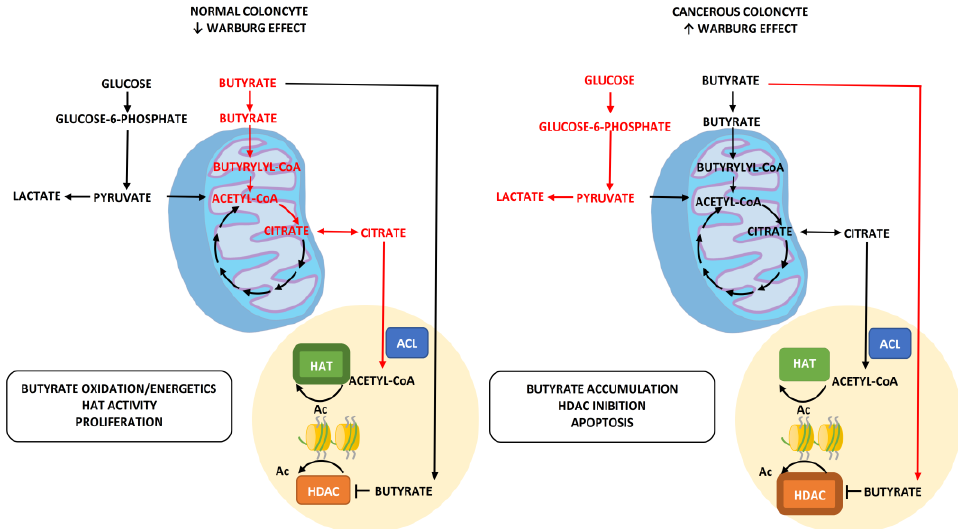
Figure 3. Oncosuppressive role of butyrate. Under normal conditions, butyrate is mainly used as an energy producer by cells. In those tumors, the energy is obtained in particular from glucose (Warburg effect) and the excess butyrate is sent to the nucleus where, being a natural acetylator, it contributes to a tumor antiproliferative